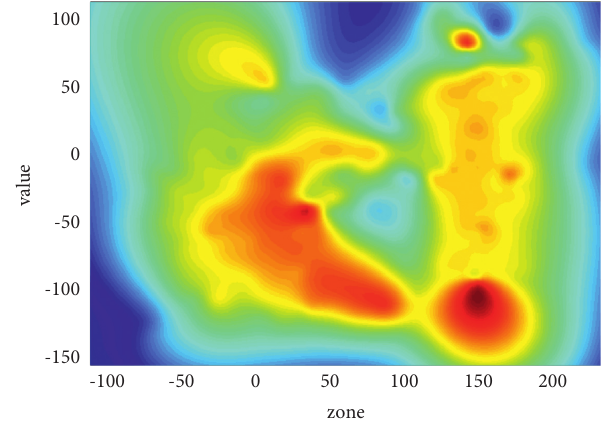
Figure 6: Value in different zones.